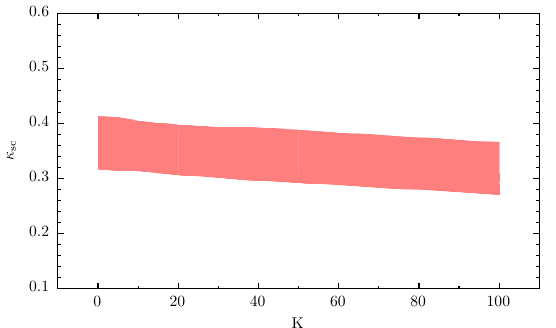
Figure 1 . When we introduce transverse momentum broadening via a nonzero value of the broad- ening parameter K , this introduces a small increase in energy loss. This means that for each nonzero value of K we need to re(cid:12)t the value of the energy loss parameter (cid:20) sc to the measured value [49] of R jet for jets with 100 GeV < p T < 110 GeV and 2 < (cid:17) < 2, as in refs. [148, 149]. The resulting AA (cid:0) dependence of (cid:20) sc on the broadening parameter K is mild. As in refs. [148, 149], the width of the band of values of (cid:20) sc in this (cid:12)gure (and the consequent widths of the bands depicting our hybrid model predictions in subsequent (cid:12)gures) comes both from the error bar on the experimentally mea- sured data point used to (cid:12)x (cid:20) sc and from varying the crossover temperature T c as described in section 2 in order to get some sense of the systematic uncertainties in the hybrid model.